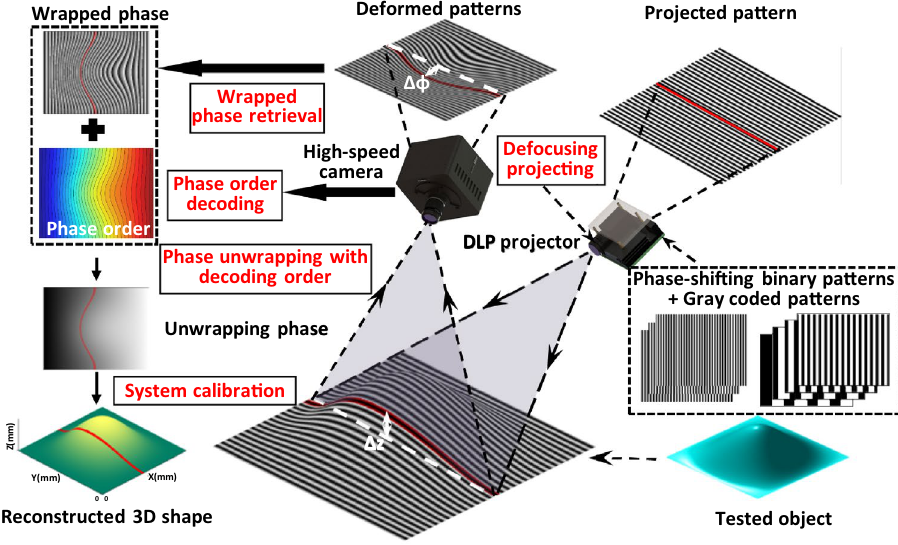
Figure 1. Schematic diagram of a FPP system for 3D shape